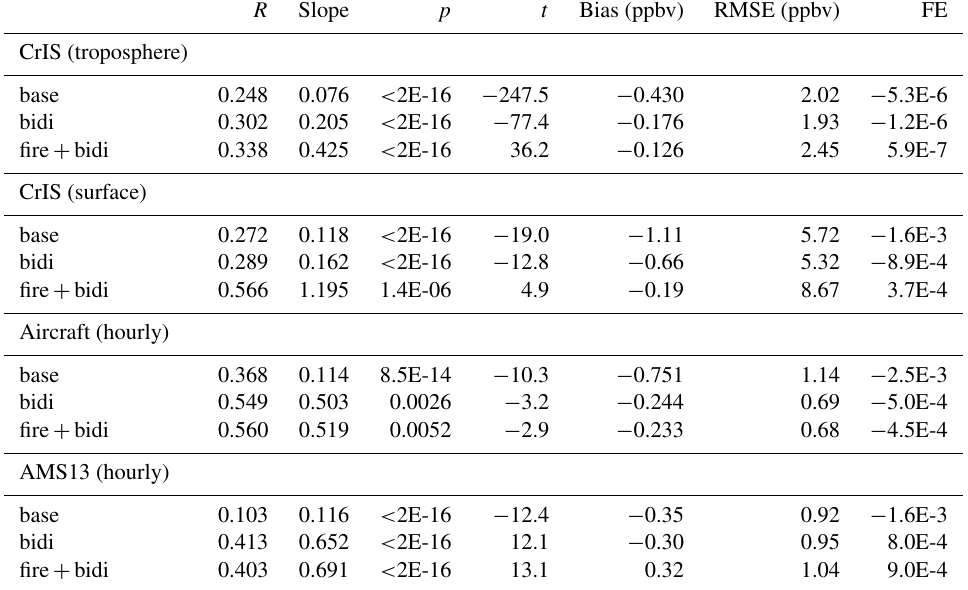
Table 2. Model–measurement NH 3 comparison statistics from 12 August to 7 September 2013: R is correlation coefficient; slope is of the line-of-best-fit between model vs. measurement; p and t are from a paired t test between model and measurement data pairs ( p > 0.05 and | t | < 1 means that the model is statistically indistinguishable from measurements); the median model bias; RMSE is the root mean square error; and FE is the fractional error of the models. CrIS (troposphere) results are for the entire model domain at all tropospheric levels shown in Fig. 9(top), and CrIS (surface) results are for the lowest retrieval level (both are during mid-day satellite overpass times); aircraft results are from the 12 flight paths over the oil sand facilities, hourly averages during the daytime; and AMS13 results are from hourly data (day and night) at the one ground